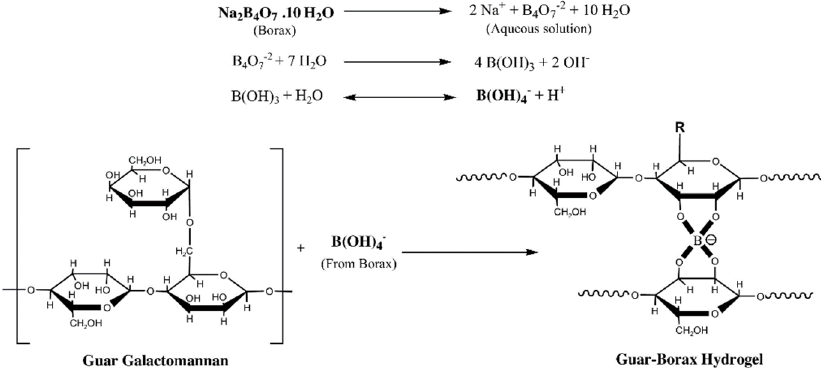
Figure 5. Borax crosslinked guar gum hydrogels [60].